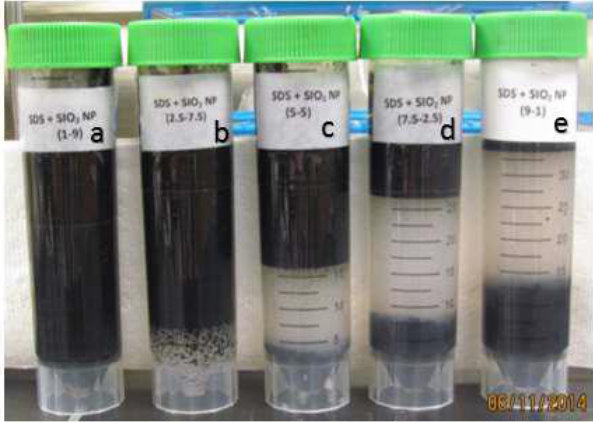
Figure 8—SDS with SiO at 25℃. Notice the settled precipitate on the 2